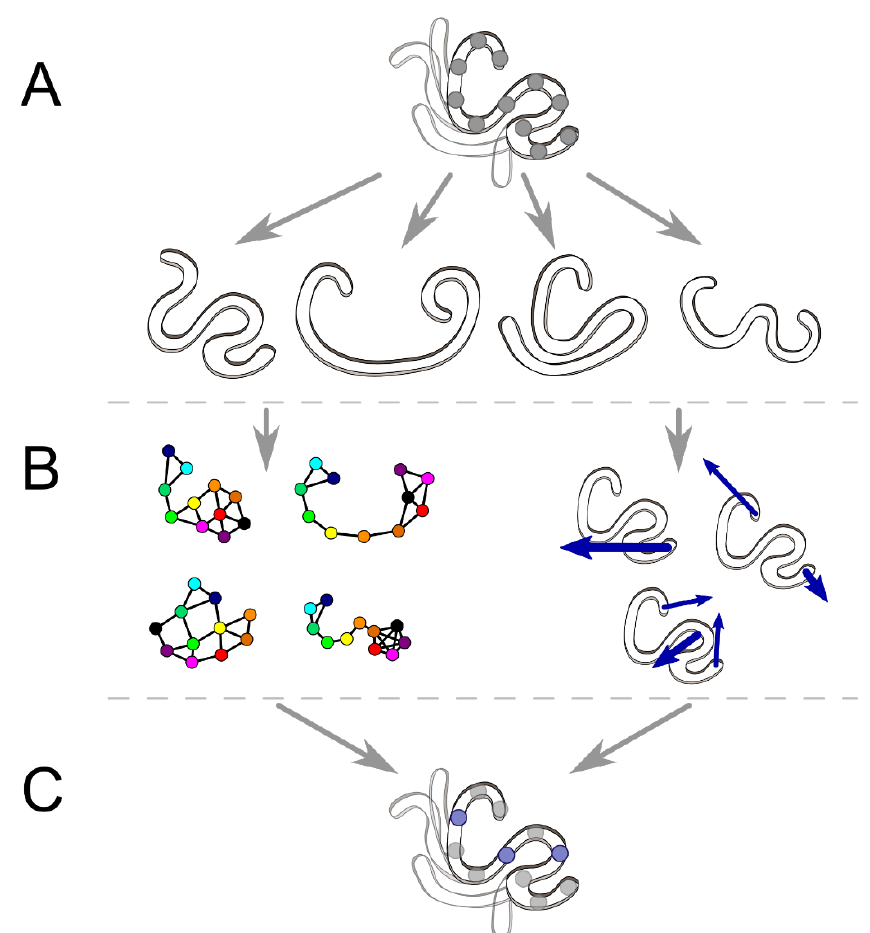
Figure 2. Predicting engineering hotspots for protein dynamics based on analyses of interaction networks and coordinated movements. ( A ) Functional protein dynamics can be represented by a conformational ensemble of a given protein. ( B ) This ensemble can be subjected to contact analysis to identify residue–residue interaction networks (left) or subjected to PCA to reveal coupled movements indicated by blue arrows right). ( C ) Either of these two approaches or their combination and hotspot residues (blue spheres) essential for the dynamics or allosteric communication can be selected for engineering.